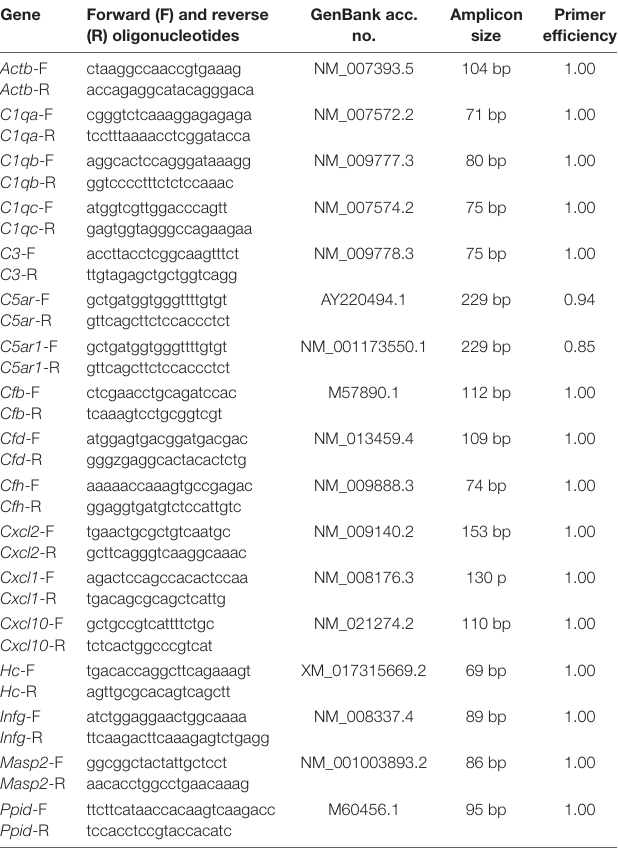
TABLE 1 | Sequences of oligonucleotides. Gene Forward (F) and reverse (R) oligonucleotides